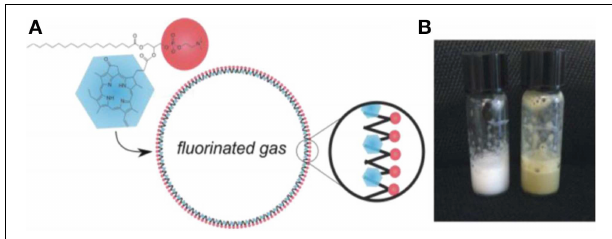
FIGURE 10 | (A) Schematic of the structure of microbubble (B) Photo of microbubbles solutions in room temperature (Adapted with permission from Huynh